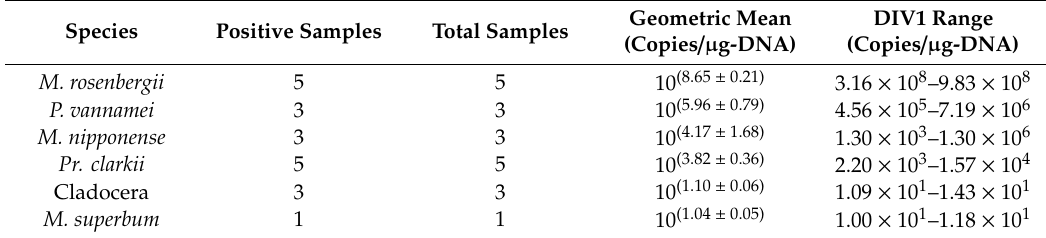
Table 1. Samples detected with the real time PCR for DIV1.